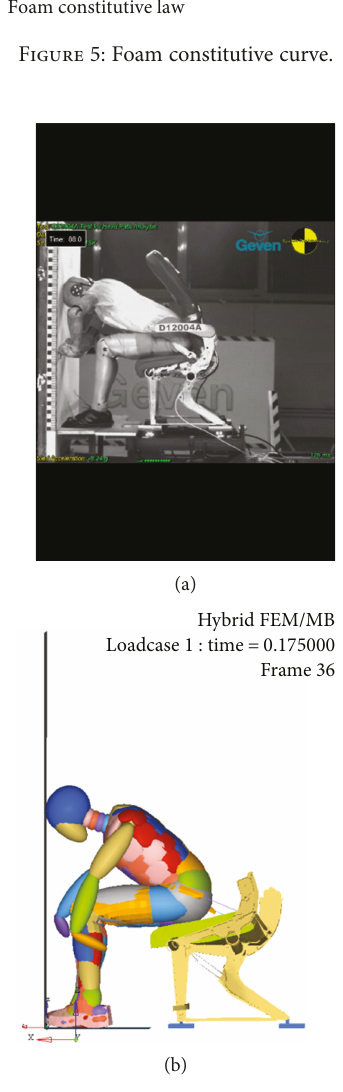
Figure 6: Experimental test (a) and hybrid model